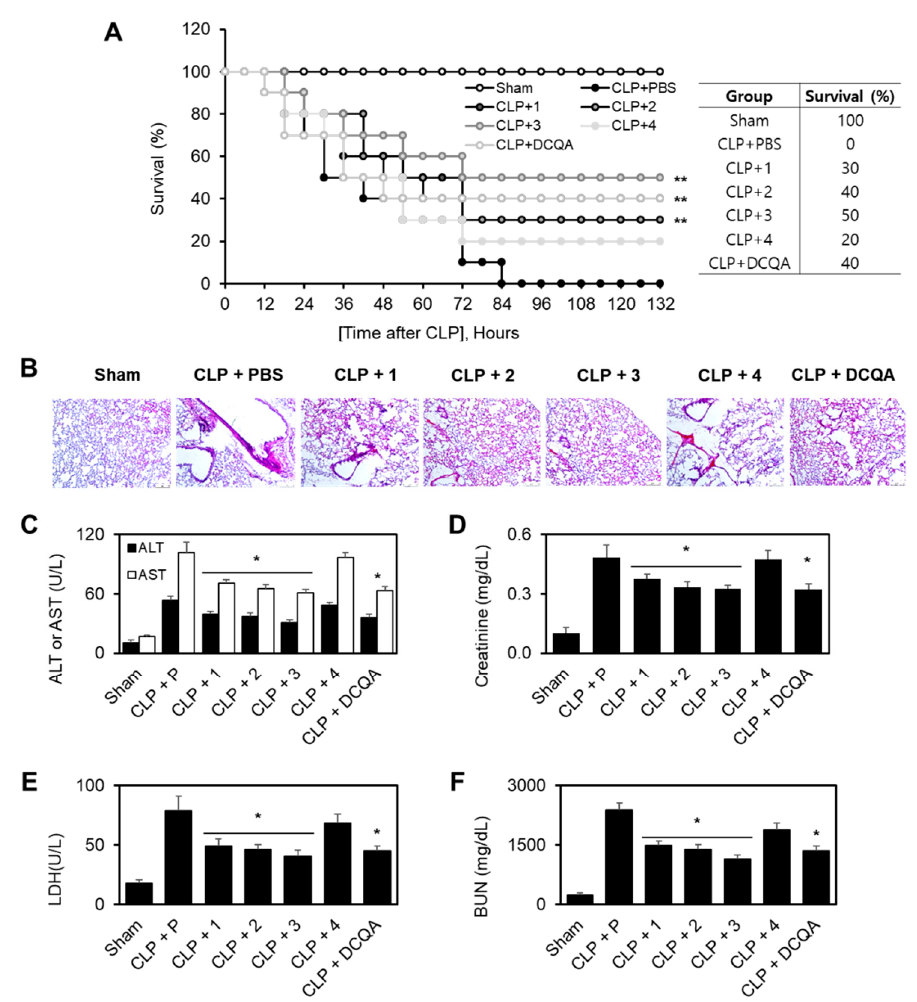
Figure 5. Effects of each compound on cecal ligation and puncture (CLP)-induced mortality and pulmonary injury. ( A ) Male C57BL/6 mice ( n = 10) were intravenously treated with each compound (0.26 mg/kg) or DCQA (1 mg/kg, positive control at 12 and 50 h after CLP. Animal survival was monitored every 6 h after CLP for 132 h. Kaplan–Meier survival analysis was performed for evaluating of the overall survival rates; ( B ) Male C57BL/6 mice underwent CLP and were administered each compound (0.26 mg/kg) intravenously at 12 and 50 h after CLP ( n = 5). Mice were killed 96 h after CLP. Photomicrographs of lung tissues (H&E staining, 200×, White scale bar = 50 µm). The illustrations show representative images from three independent experiments; ( C – F ) The same as ( B , C ) except that mice were bled to death. Aspartate transaminase (AST) ( C ), alanine transaminase (ALT) ( C ), creatinine ( D ), blood urea nitrogen (BUN) ( E ), and lactate dehydrogenase (LDH) ( F ) levels in the plasma were measured. The results are expressed as the means ± SD of five independent experiments ( n = 5). * p < 0.05 vs. the CLP group .